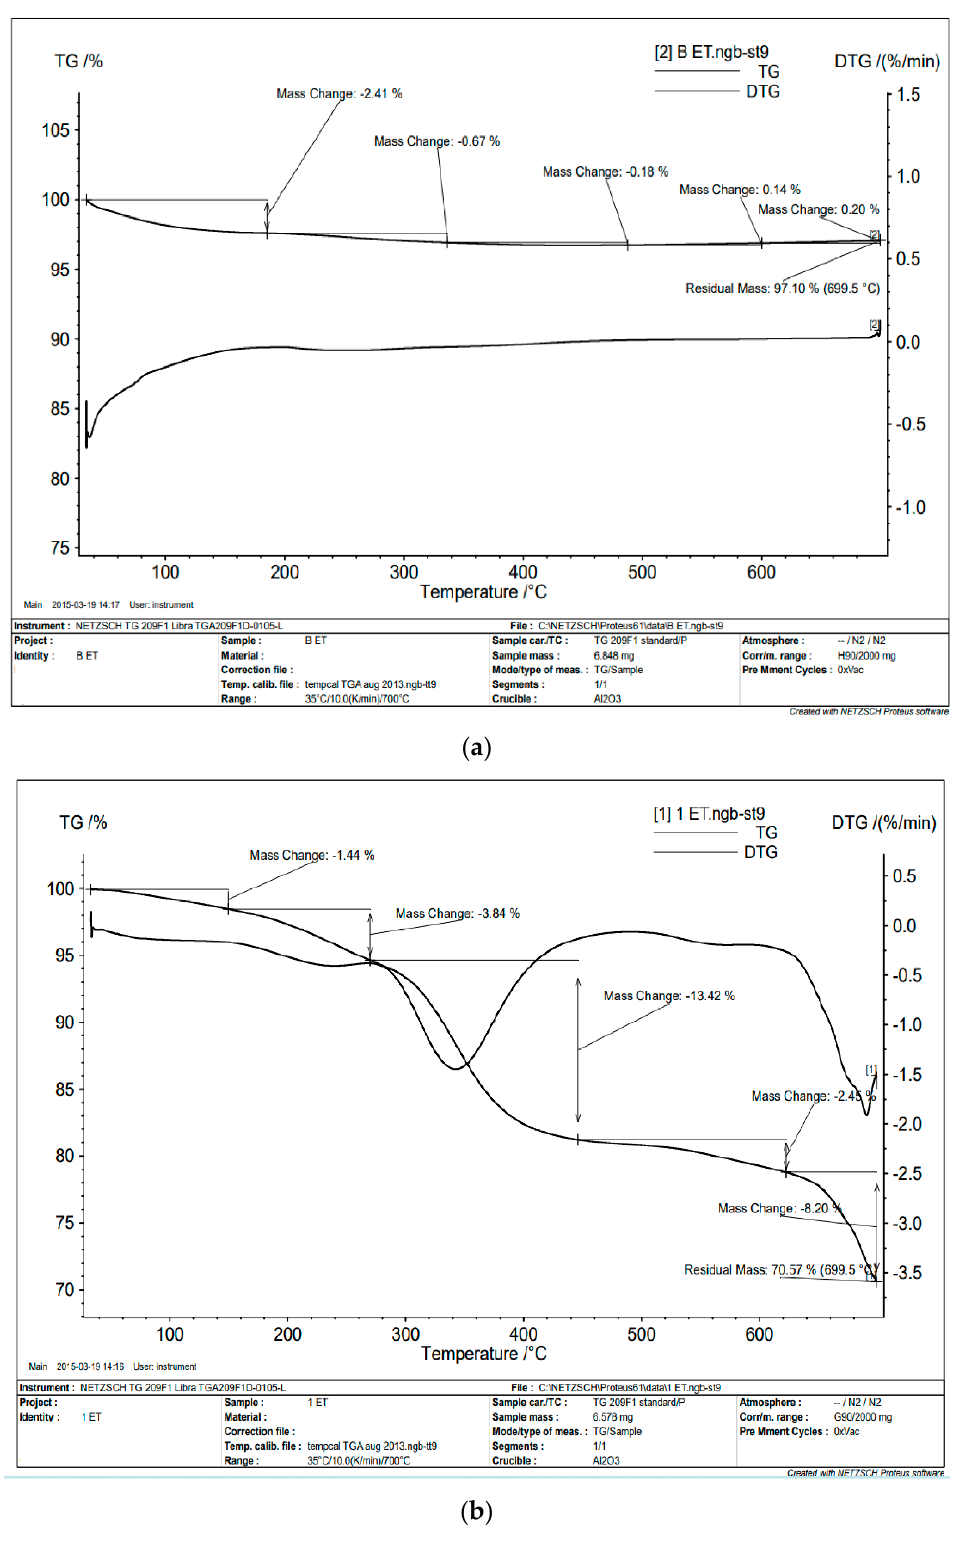
Figure 3. GA analysis for ( a ) surfactant-coated MNPs, ( b ) uncoated MNPs.